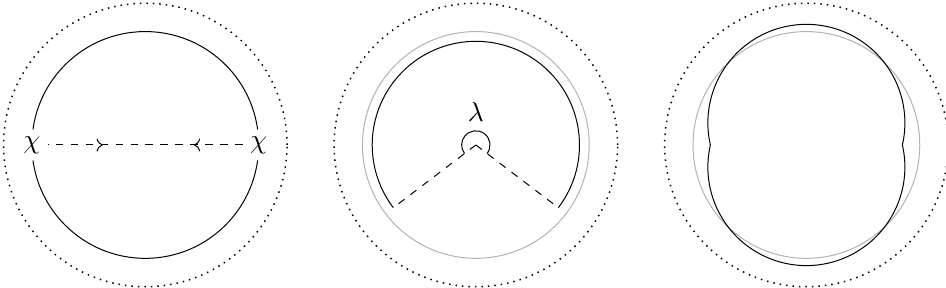
Figure 1. Overview of the computation of the saddle point. We show Euclidean AdS 2 with radial coordinate r = tanh (cid:26) [0 ; 1), with the conformal boundary drawn as a dotted line. In the (cid:12)rst 2 2 panel, we draw the saddle point at (cid:22) = 0, which is a circle of length L . We also show the operator insertions at (cid:30) = 0 ; (cid:25) that give \tension" to the solution in the (cid:22) = 0 case. In the presence of these 6 operator insertions, the true saddle is a shape that is \pinched" towards the center. The solution will consist of two circular segments. In the second panel, we show the top circular segment in a coordinate where its center is at r = 0, with the (cid:22) = 0 saddle for reference. The length of each segment is (cid:12)xed to L= 2, so for an inner angle (cid:21) > (cid:25) , the radius of the circle must shrink accordingly. In the last panel, we show the (cid:22) = 0 saddle in a coordinate that is symmetric 6